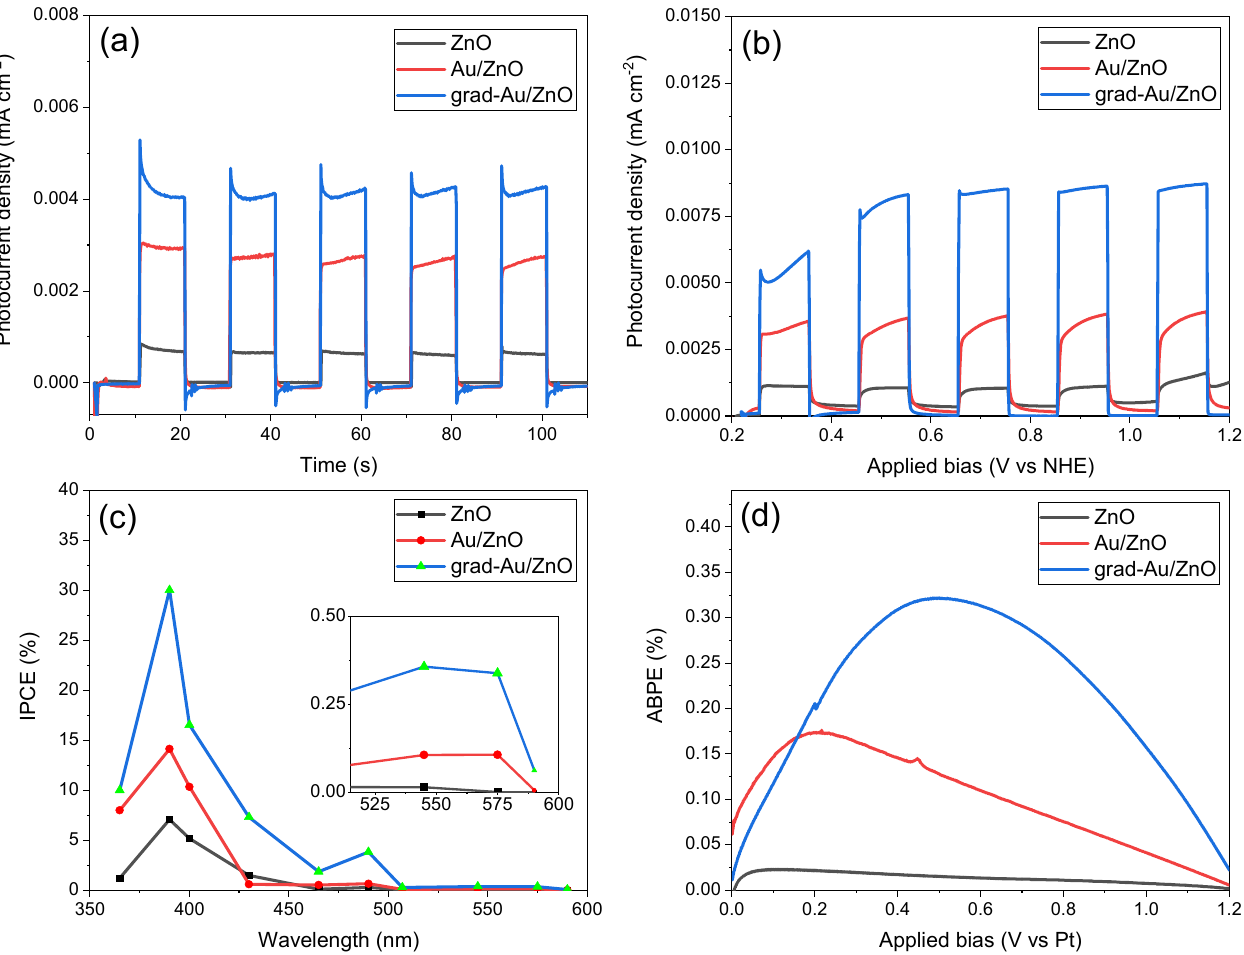
Figure 6. ( a ) Chronoamperometric photoresponse; ( b ) linear sweep voltammetry; ( c ) IPCE at an ap- plied bias of 1.2 V vs. NHE; and ( d ) ABPE efficiencies of ZnO, Au/ZnO, and grad-Au/ZnO pho- toanodes.